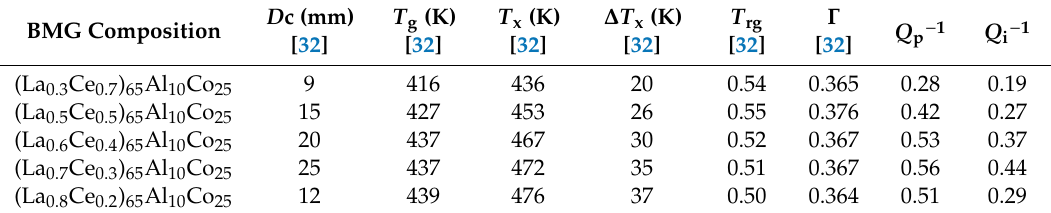
Figure 3. Comparison of the Q − 1 – T curves of the LaCe-based BMGs with the driving frequencies of ( a ) 0.5 Hz and ( b ) 10 Hz, respectively. Table 1. The GFA parameters ( D c [32], T g [32], T x [32], ∆ T x [32], T rg [32], and γ [32]), IF peak values ( Q p − 1 ) with a driving frequency of 0.5 Hz, and inflection point IF values ( Q i − 1 ) with the driving frequency of 0.5 Hz of LaCe-based BMGs.